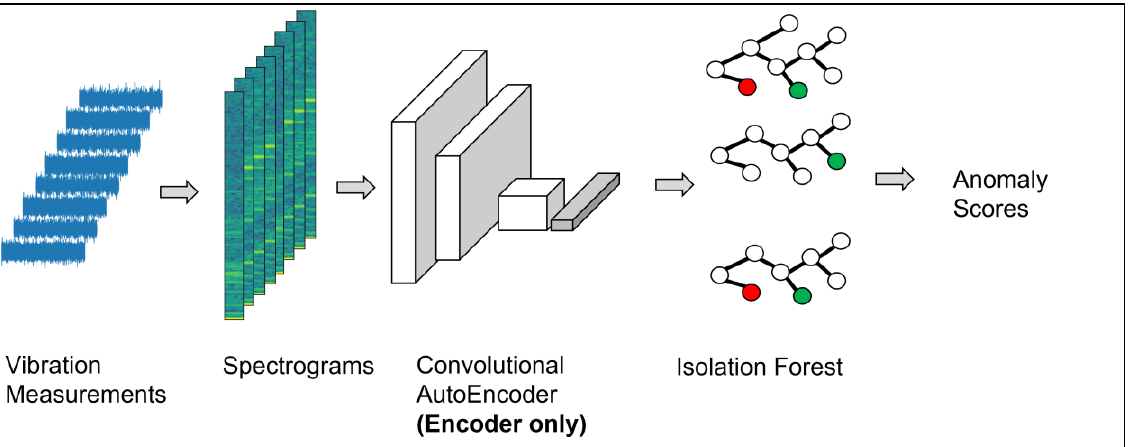
Figure 2. An illustration of the fault detection approach based on isolation forests. First, the vibration measurements are converted to spectrogram segments. The segments are given as input to the encoding part of a convolutional autoencoder, the last layer outputs of which are an encoded representation of the segment features (shaded layer). Then, an isolation forest model computes an anomaly score for each segment. The score is used as a health index to distinguish healthy and fault-affected components.